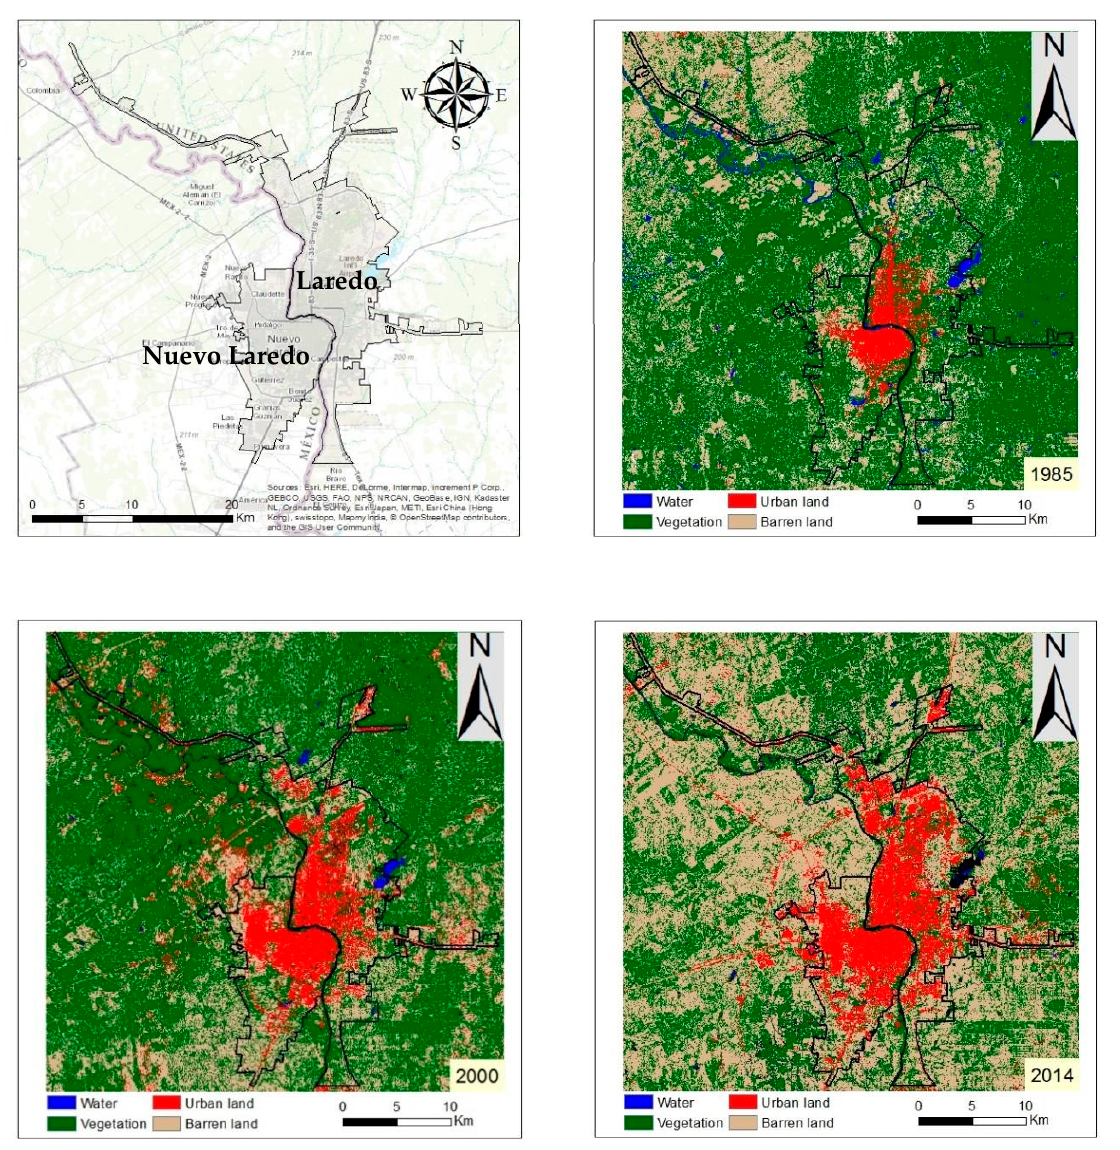
Figure 1. The Laredo–Nuevo Laredo study area and corresponding land cover in 1985, 2000, and 2014.